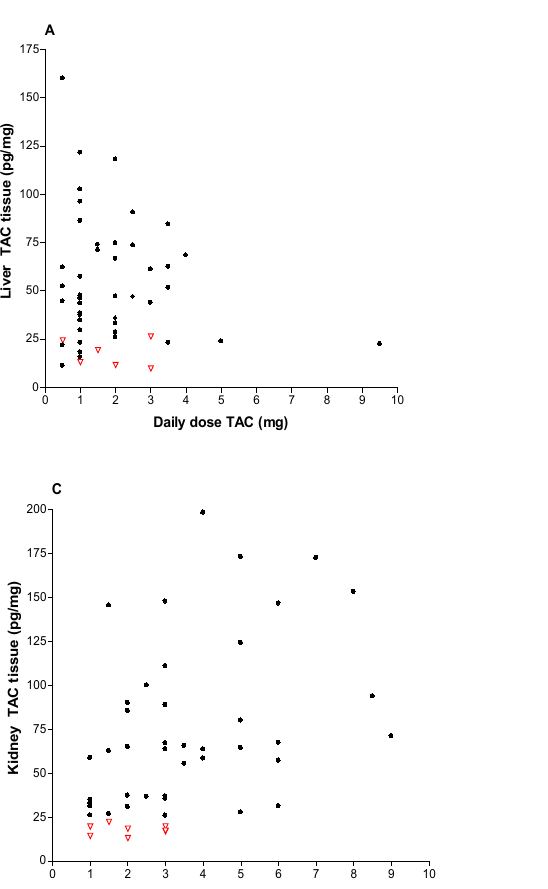
Figure 4. Liver tissue and blood TAC levels determined in 50 transplant patients. 4. Discussion From the point of view of the site of action, the ideal matrix for TDM of immunosup- pressive agents would be the target tissue of transplanted organs or target cell: lympho- cytes and peripheral blood mononuclear cells (PBMC). However, due to several reasons, we are still very far from adopting them into routine clinical practice. The lack of stand- ardization of data, the variability in cellularity of biopsies, the impact of matrix effect and blood contamination are among reasons for not adopting them in clinical practice. In sev- eral investigations, intragraft and intracellular TAC concentrations were suggested to pre- dict transplant outcomes better [5,6,8–10,15–22]. Moreover, tissue TAC concentrations within the allograft might provide understanding of TAC distribution during graft rejec- tion more precisely. Therapeutic drug monitoring of immunosuppressive agents requires precise and ac- curate analytical methods, especially for the lower ranges of concentrations. Several ap- proaches have been proposed for an LC-MS/MS procedure for this purpose [23–26]. The LC-MS/MS method displayed precision and accuracy suitable for application to Tacroli- mus measurements in human kidney and liver biopsy tissues. In discussing the developed and validated LC-MS/MS method, it has to be noted that the chromatographic conditions